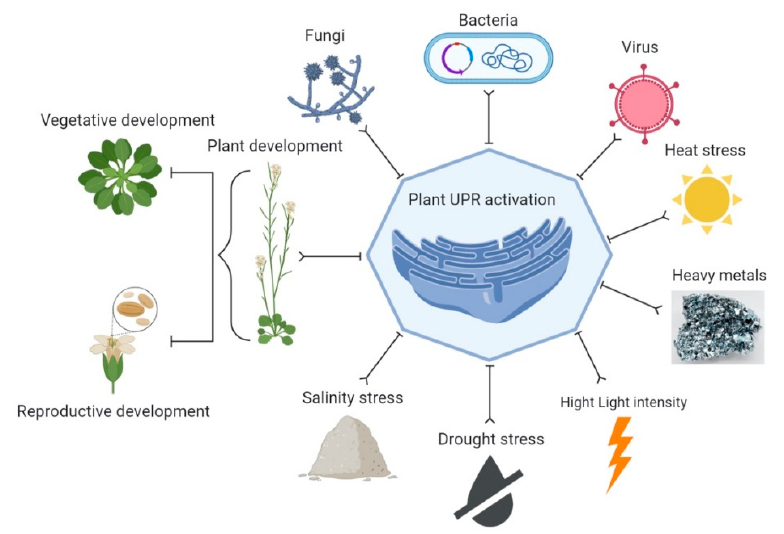
Figure 2. Activation of the UPR. A variety of stresses (biotic and abiotic) and plant development processes (vegetative and reproductive) trigger the UPR by excessive accumulation of unfolded proteins in the ER or cause an imbalance in the supply of amino acids, which leads to the activation of one or more UPR arms. This figure was created by using BioRender